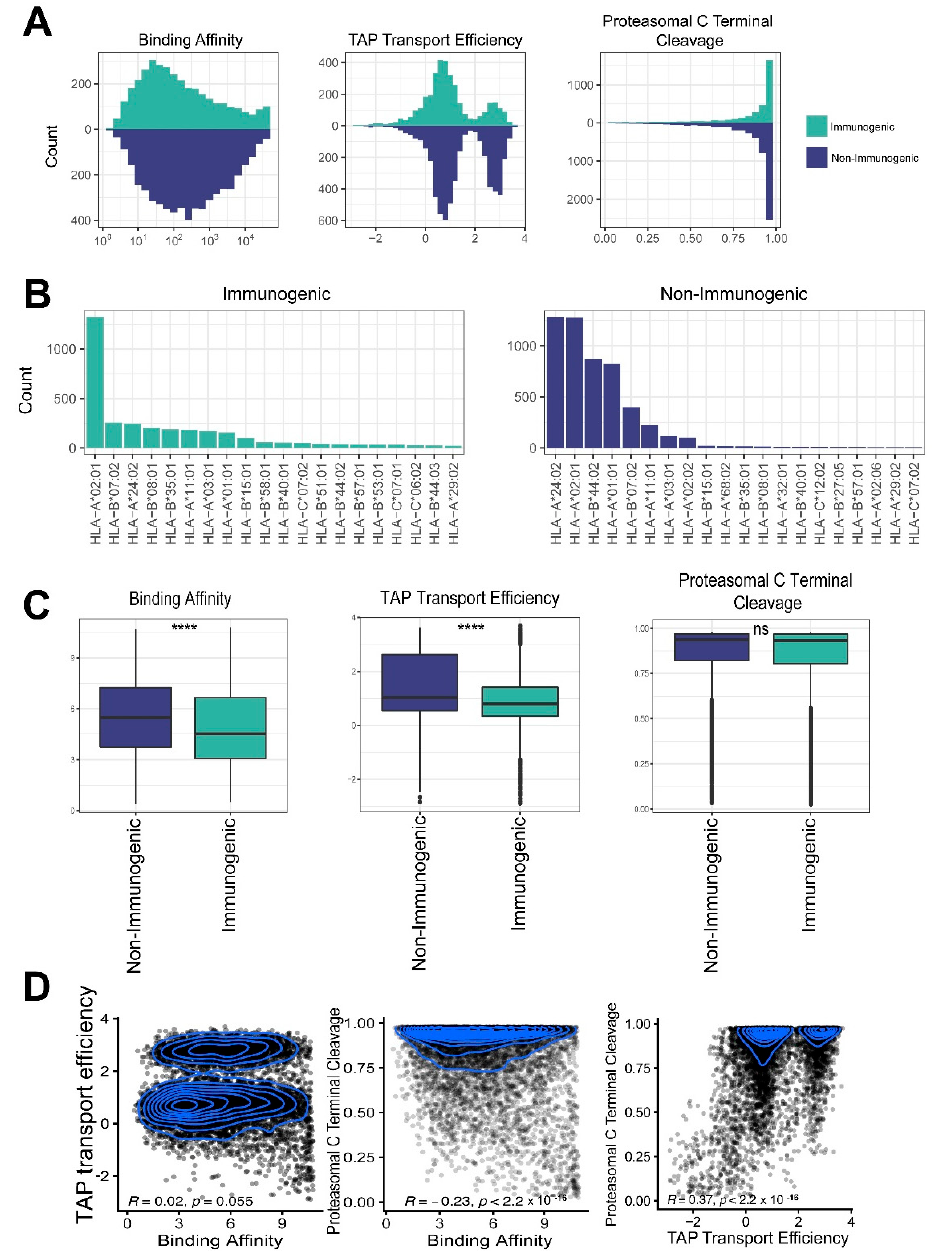
Figure 4. An exploration of the feature differences between immunogenic and non-immunogenic peptides: ( A ) a distribution comparison of HLA I binding affinity, TAP transport efficiency and proteasomal C terminal cleavage between immunogenic and non-immunogenic peptides; ( B ) a distribution comparison of the binding of the 20 most frequent HLA-I alleles to the immunogenic (left) and non-immunogenic mutated peptides (right); ( C ) a comparison of binding affinity, TAP transport efficiency and proteasomal C terminal cleavage between immunogenic and non-immunogenic mutated peptides (****, p < 10 − 4 ; ns, not significant); ( D ) pairwise correlations between the three neoepitope features (peptide–HLA binding affinity, TAP transport efficiency and proteasomal C terminal cleavage), showing the Pearson correlation coefficients R and p values.